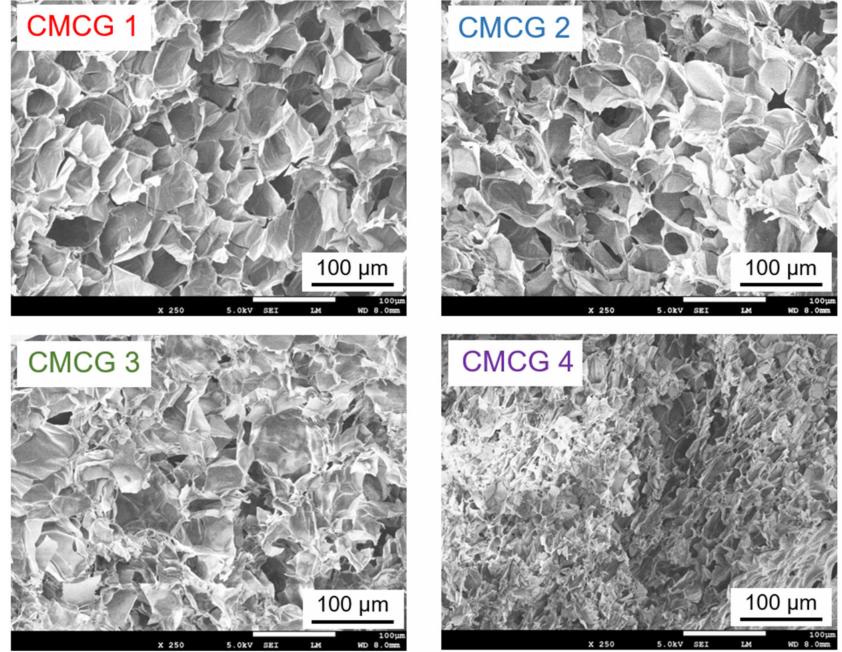
Figure 11. Scanning electron microscopy (SEM) images for the cross-sectional surface of the CMCG 1–4 species swelled in